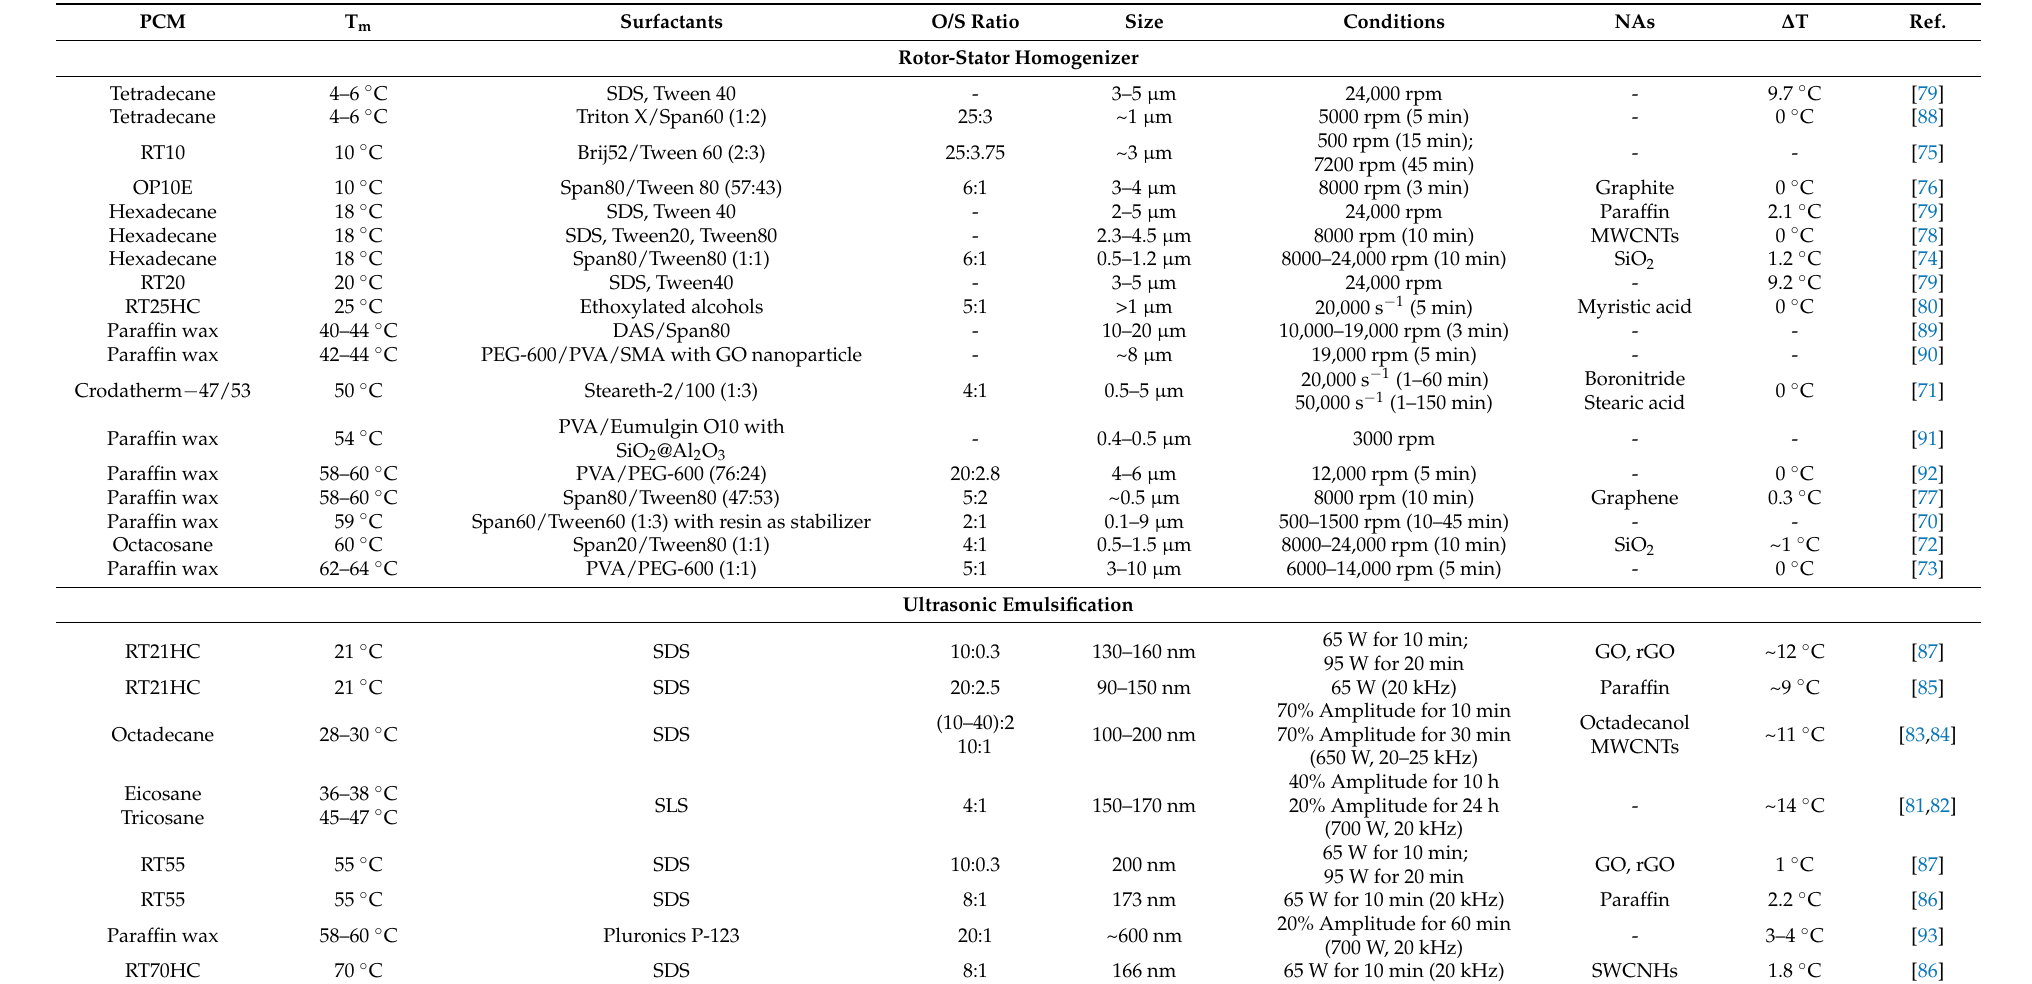
Table 4. Summaries of PCM emulsions fabricated by high-energy